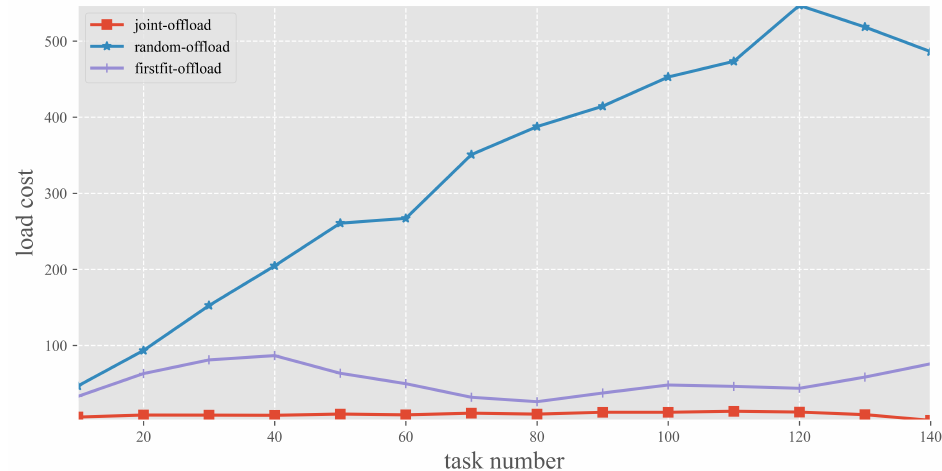
Figure 14. Load balance cost of the three offloading strategies varies with the number of tasks in the whole constellation offloading scenario.